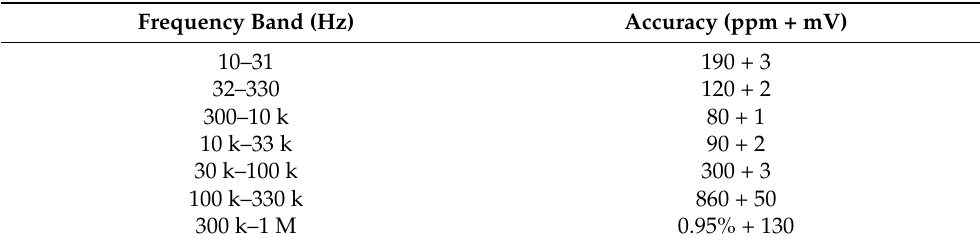
Table 3. Accuracy specifications of the Datron Wavetek 4800 calibrator for the 100 V